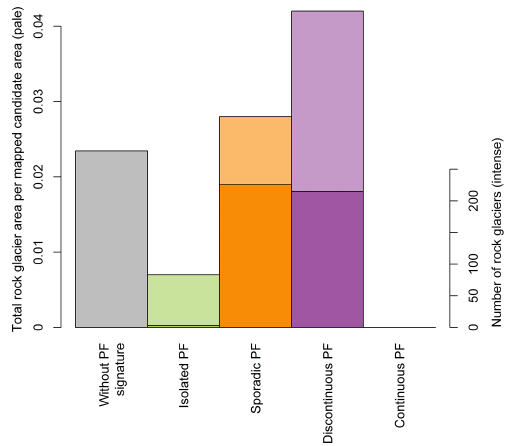
Figure 6. Mapped rock glaciers in relation to the Permafrost Zona- tion Index summarized over the mapped HKH region. Mapped can- didate area refers to areas in which rock glaciers can be expected to occur and to be observed; for each pixel, this is determined based on (a) topography (standard deviation of SRTM90 > 85m in each sample), (b) sufficient image quality in Google Earth, and (c) the absence of glacier cover. The same colors as for the PZI map have been used where dark blue indicates permafrost in nearly all condi- tions and bright yellow indicates permafrost only in very favorable conditions. Green indicates the fringe of uncertainty. Intensive col- ors indicate the number of rock glaciers and pale colors represent the density of rock glaciers within a certain class. For more infor- mation on the PZI see Gruber (2012).